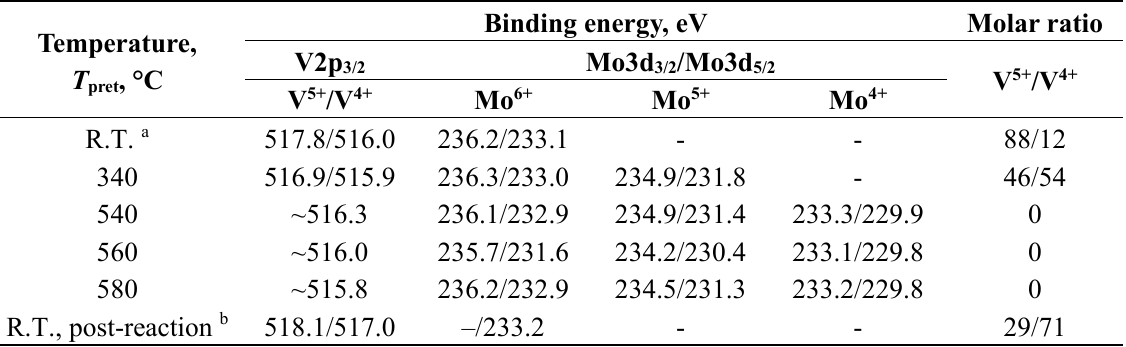
Table 4. Surface analysis results for V and